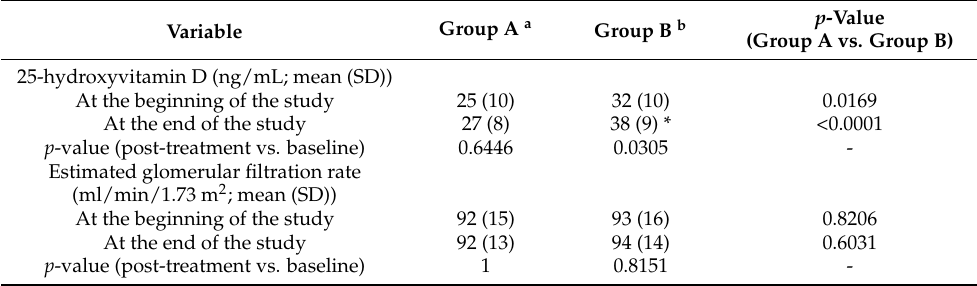
p -Value (Group A vs. Group B)